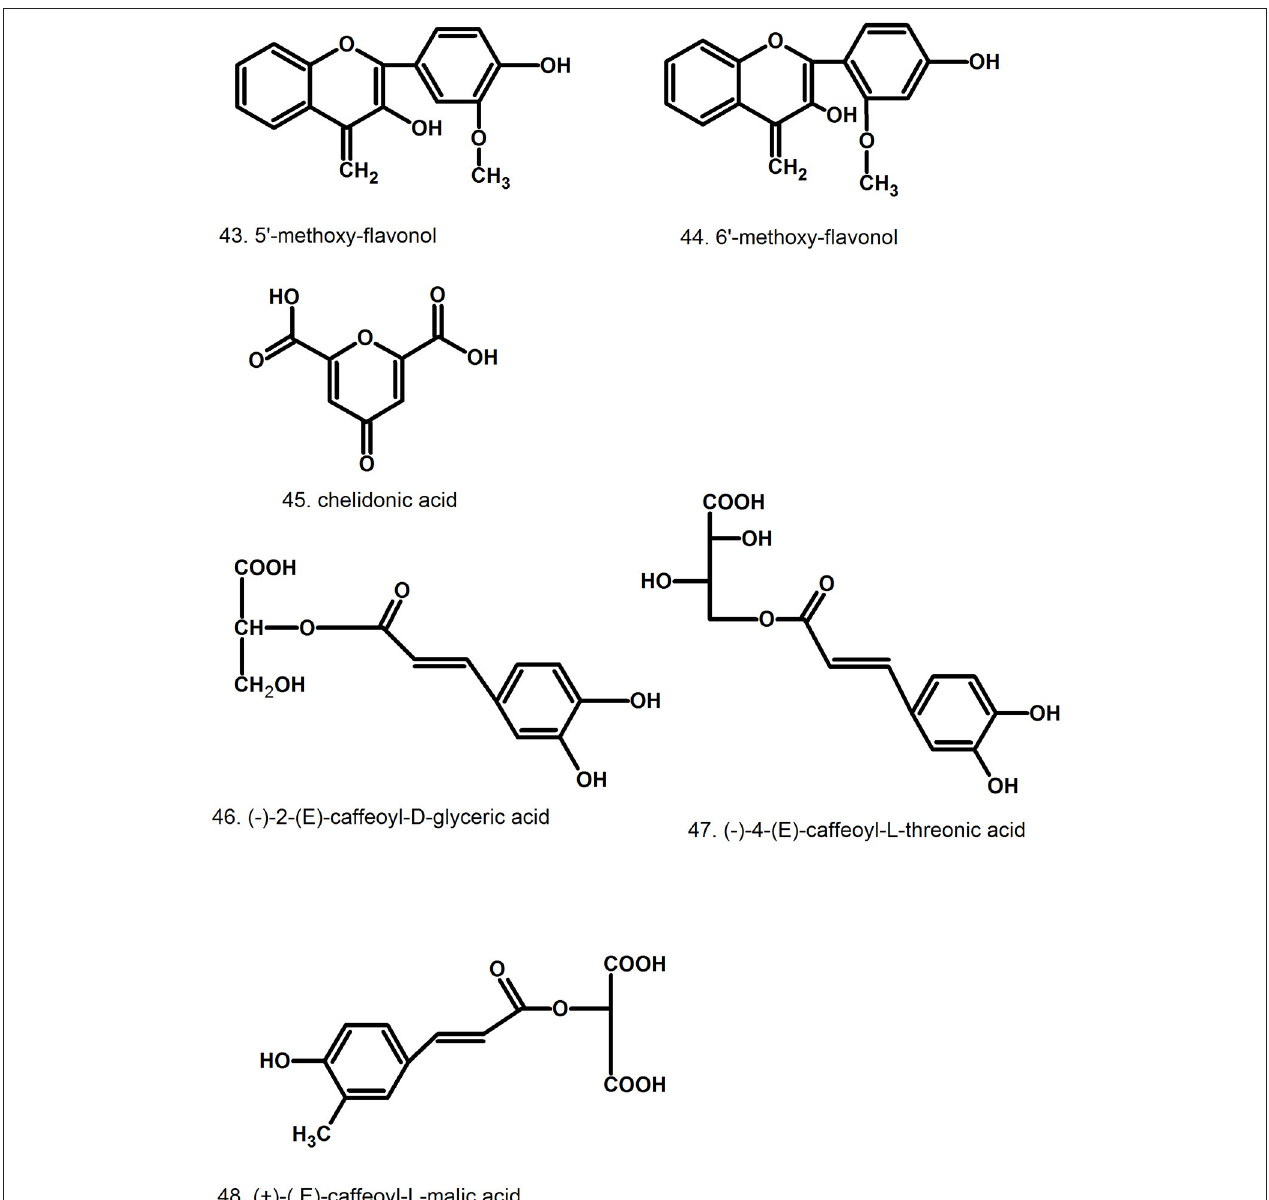
FIGURE 7 | Structures of miscellaneous